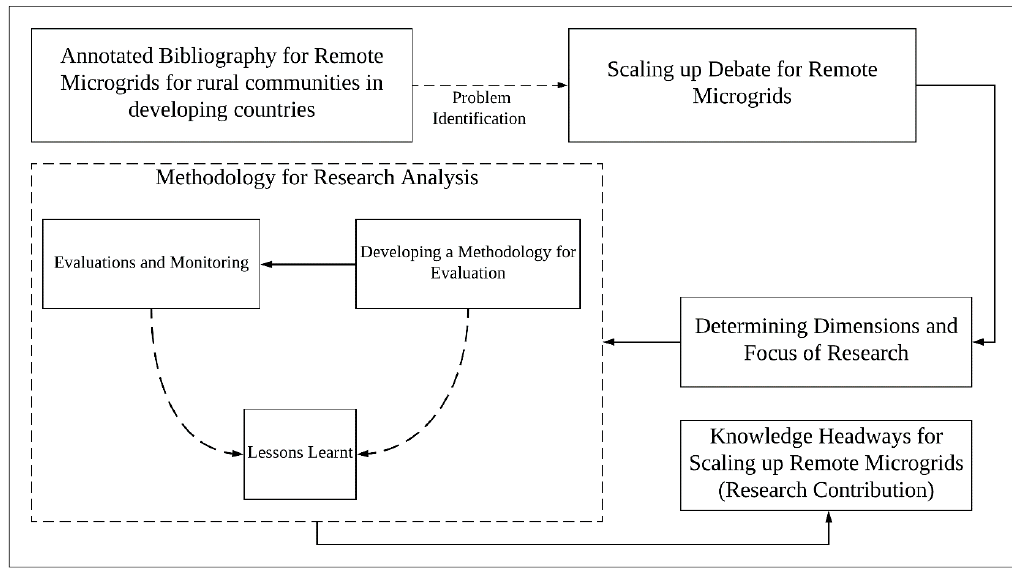
Figure 2. Scheme and the objective of the paper.